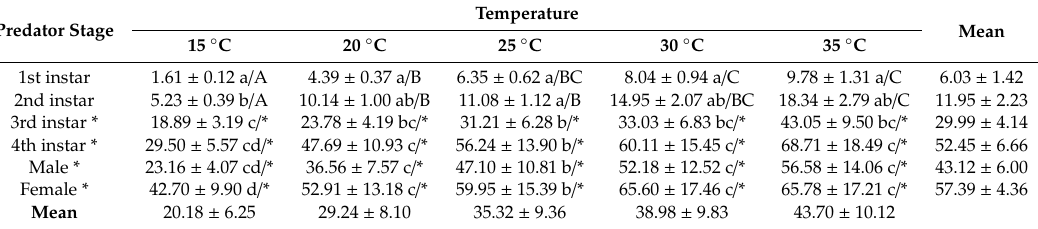
Table 1. Mean prey consumption ( ± SE) rate on Spodoptera litura eggs by Harmonia axyridis at various predatory stages and